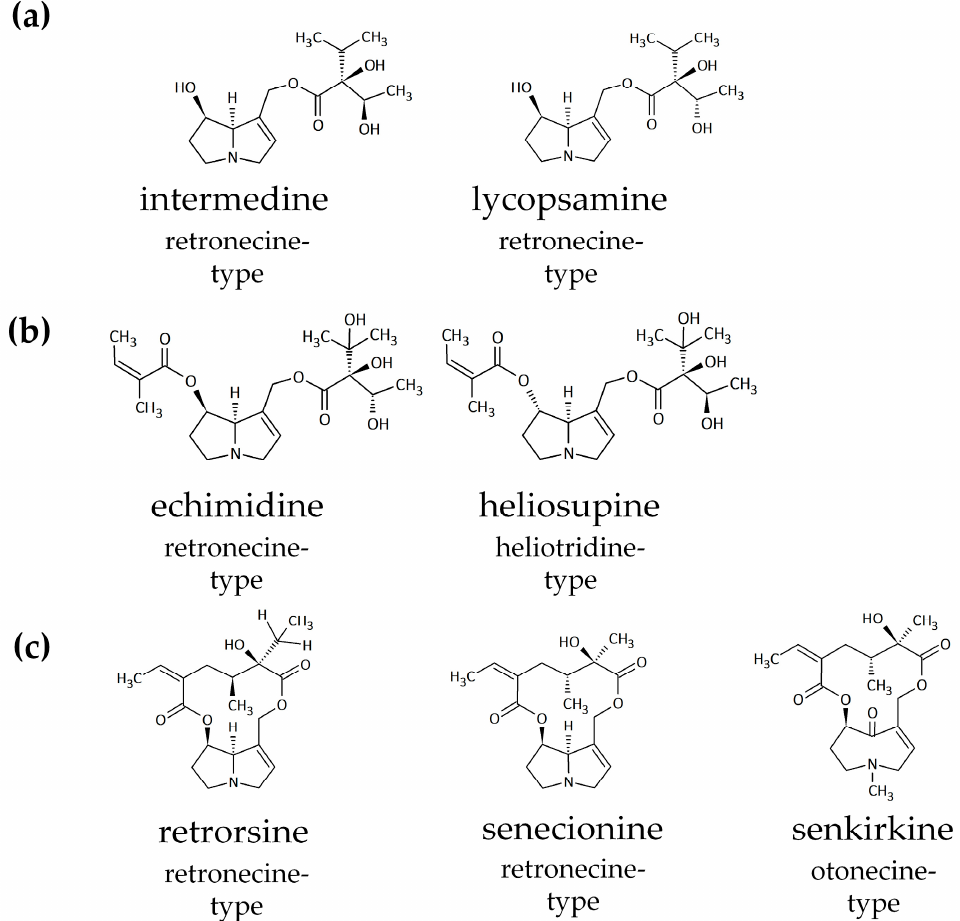
Figure 1. Chemical structures of 1,2-unsaturated pyrrolizidine alkaloids (PAs) used in this study, representing the main structural characteristics of their necine base (retronecine-type, heliotridine-type and otonecine-type) and of their necic acids: ( a ) monoester, ( b ) open-chain diester, and ( c ) cyclic diester.